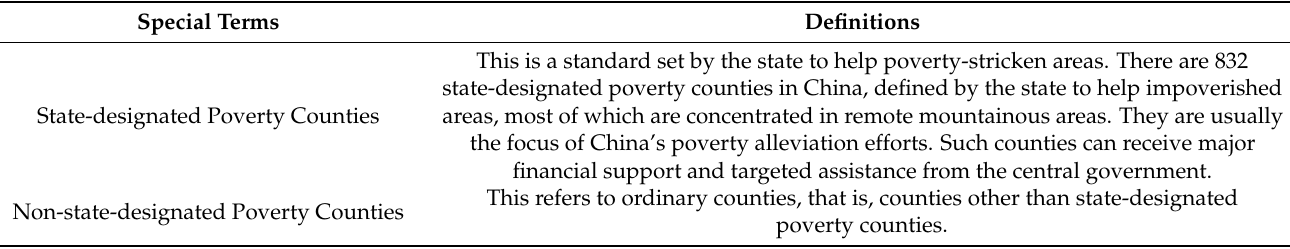
Table 1. Relevant definitions for special terms in this